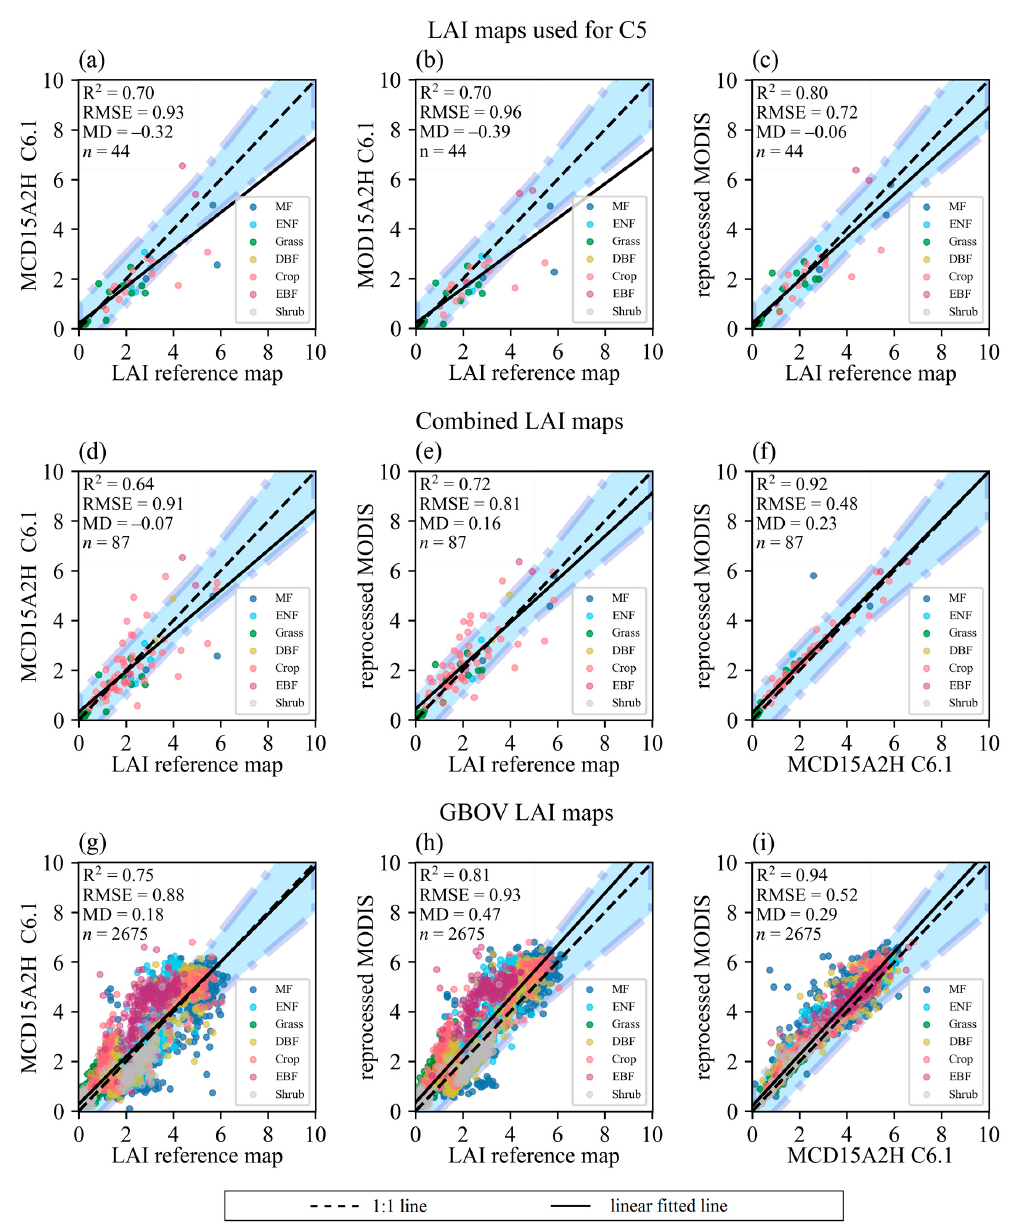
Figure 2. Validation of MODIS C6.1 LAI products and reprocessed LAI data against ( a – c ) reference maps used in the validation of MOD C5 LAI [55], ( d – f ) combined LAI reference maps (VALERI, BigFoot, Boston University, SMEX02, and ImagineS datasets), and ( g – i ) GBOV LAI reference maps. The shaded area stands for the uncertainty agreement ratio [1,74], and the distance between the diagonal and the upper or lower bound of the shaded area is equal to the greater 20% of the reference map value and 1 m 2 m − 2 . “MD” is the average difference between the LAI values shown on the y and x